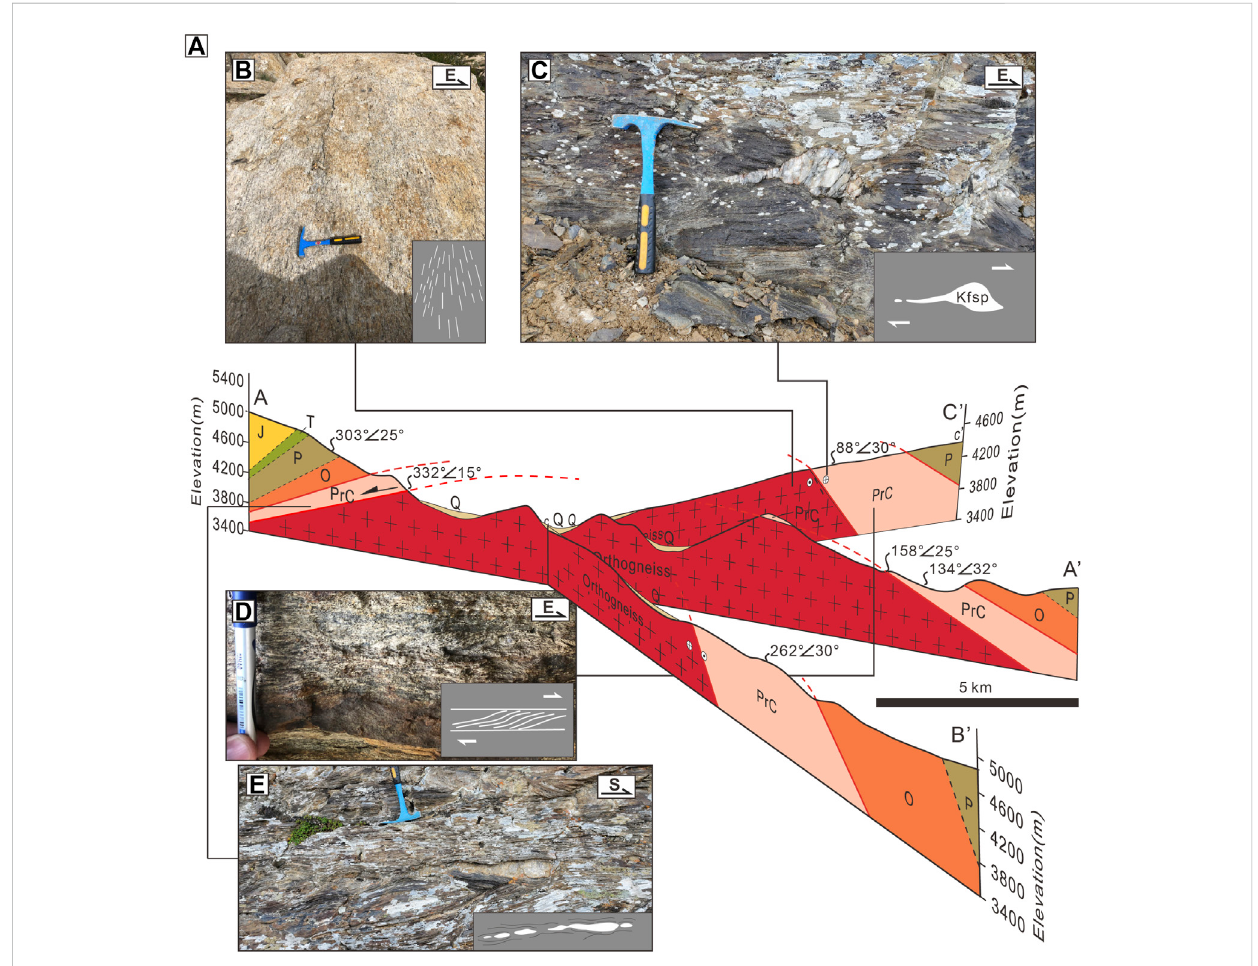
FIGURE 4 (A) Composite diagram illustrating the three-dimensional structure of the Kangmar dome. The locations of the cross-section lines and legend are shown in Figure 3A. (B – E) : Summary of kinematic structures in different positions of the Kangmar